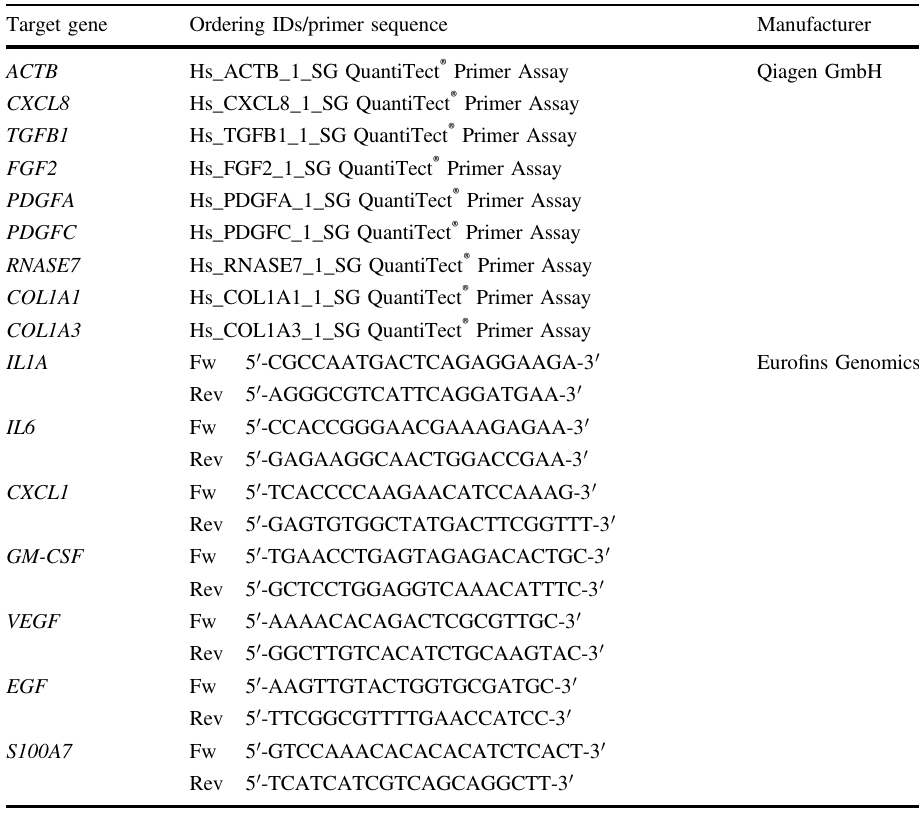
Table 1 The primer sequences and ordering IDs used for the SYBR Green-based